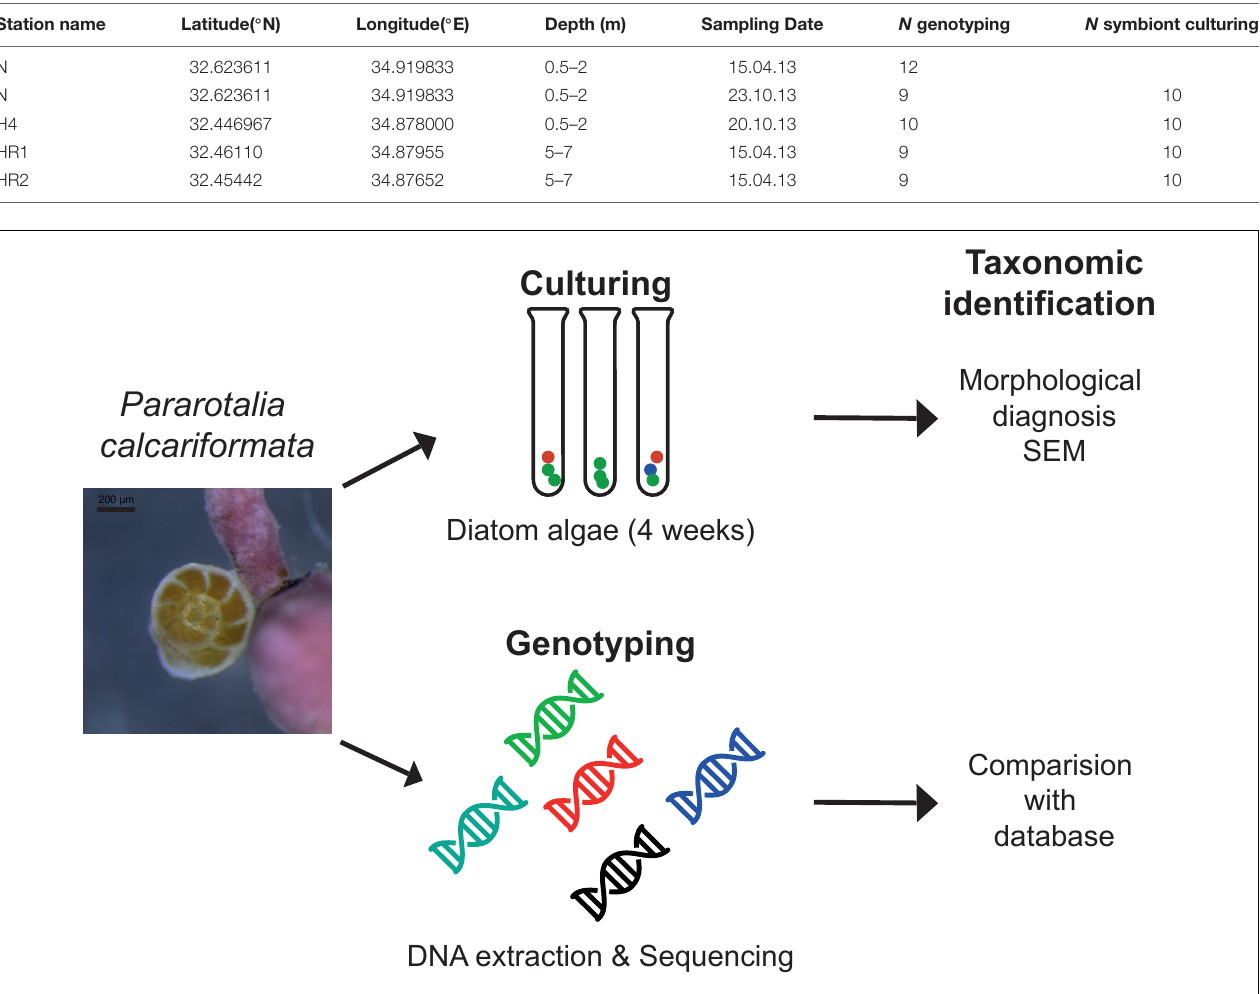
TABLE 1 | Sampling stations of the study and foraminifera or diatom cultures analyzed with the respective techniques: genotyping and standard algae culturing.